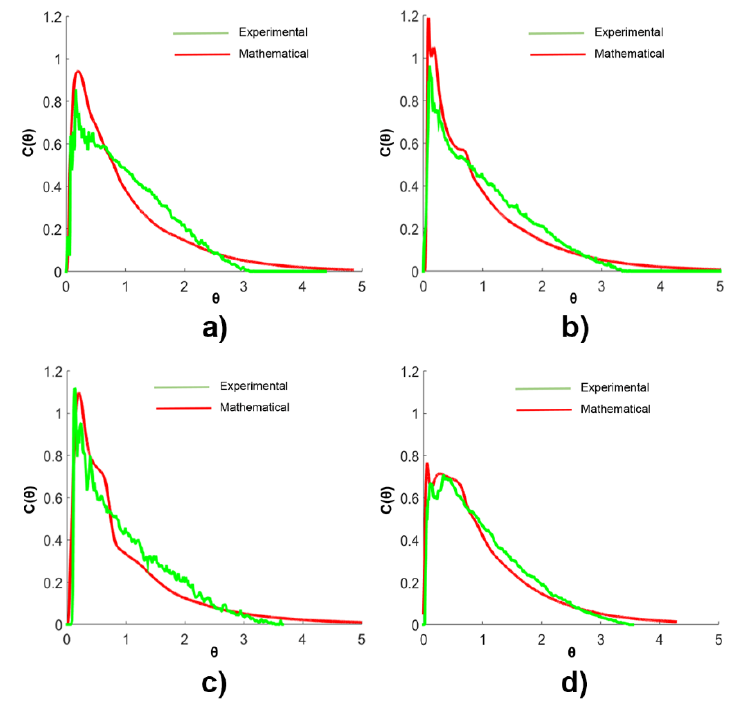
Figure 14. Experimental and numerical RTD curves: ( a ) Internal strand, TI1; ( b ) External strand TI1; ( c ) Internal strand, TI3; and ( d ) External strand, TI3.